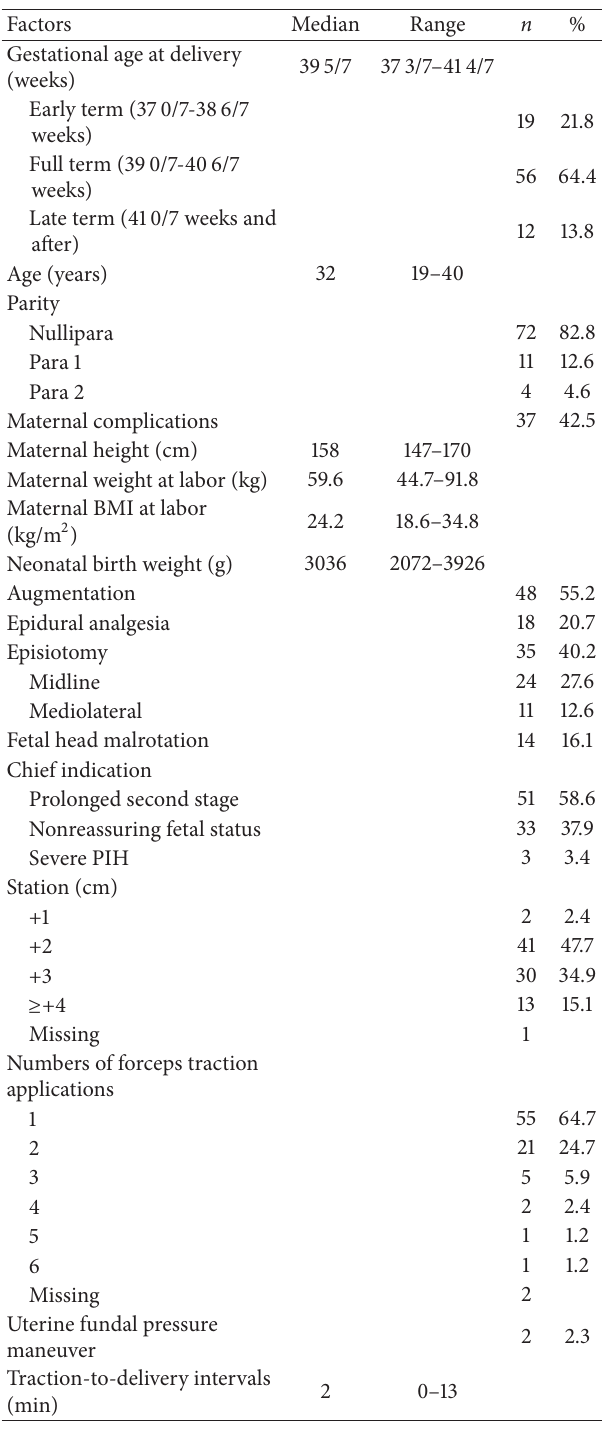
Table 1: Characteristics of the 87 pregnant women on whom Naegele forceps delivery was